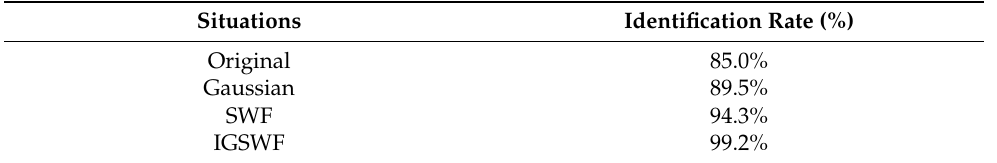
Table 2. The identification